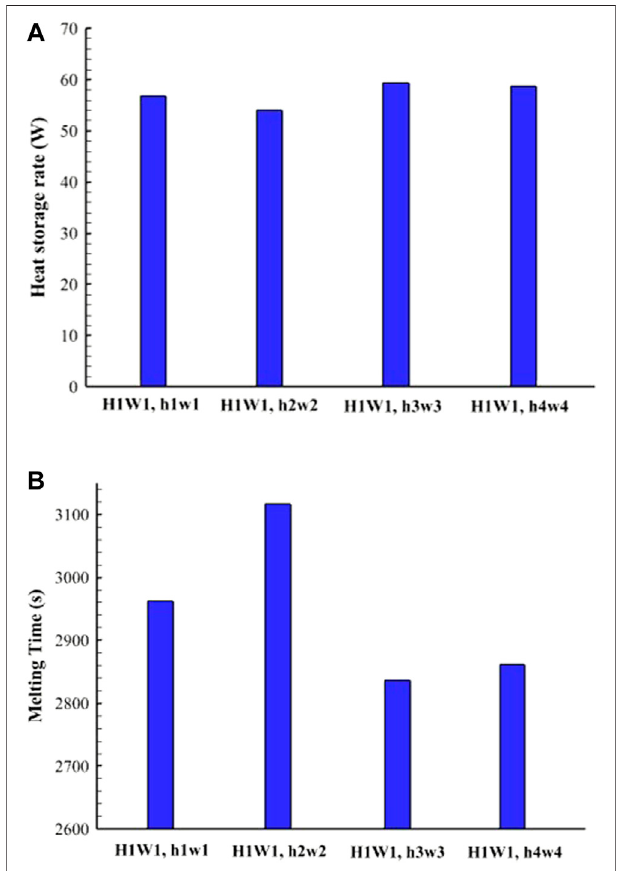
FIGURE11|(A) Liquid fraction development; (B) temperature pro fi le for various dimensions of the T-shaped fi n ’ s body [with the same size of the fi n ’ s head (H1W1)].